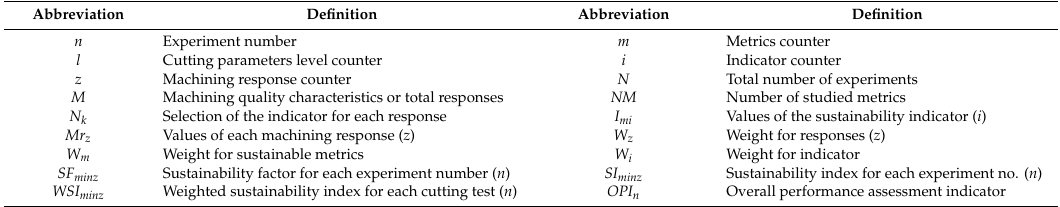
Table 5. List of the abbreviations used in the proposed